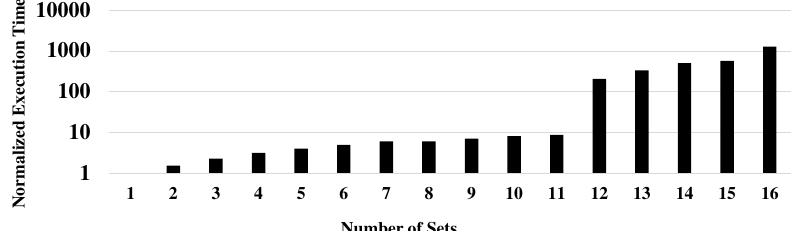
Figure 4. Average total execution time (log scaled) of multiple benchmark executions as the number of processes increases in the Shared-Memory System.